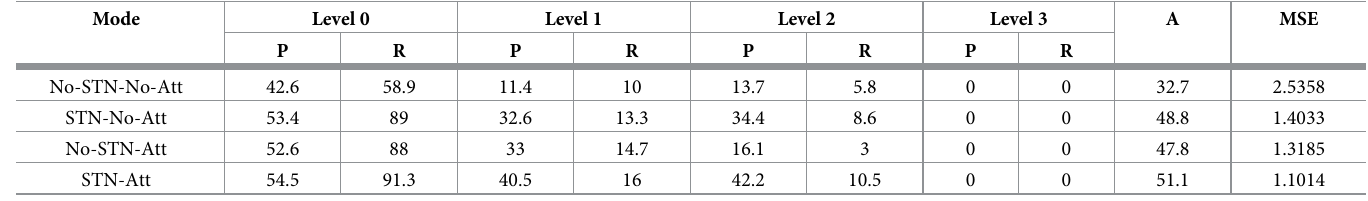
means that all samples with Level 3 are misclassified as other pain levels. As shown in Table 5, the proposed method with STN and attention mechanism classified 369 samples with Level 3 as Level 0, Level 1 and Level 2 with a number of 170, 95 and 104, respectively. By analyzing samples of different pain levels, there are some training samples that are difficult to classify. Table 4. The precision (%), recall (%), accuracy (%) and MSE of different modes of the proposed method. P denotes to precision, R denotes recall, A denotes classifica- tion accuracy, and Att is short for attention. Mode Level 0 Level 1 Level 2 Level 3 A MSE P R P R P R P R No-STN-No-Att 42.6 STN-No-Att 53.4 No-STN-Att 52.6 88 STN-Att